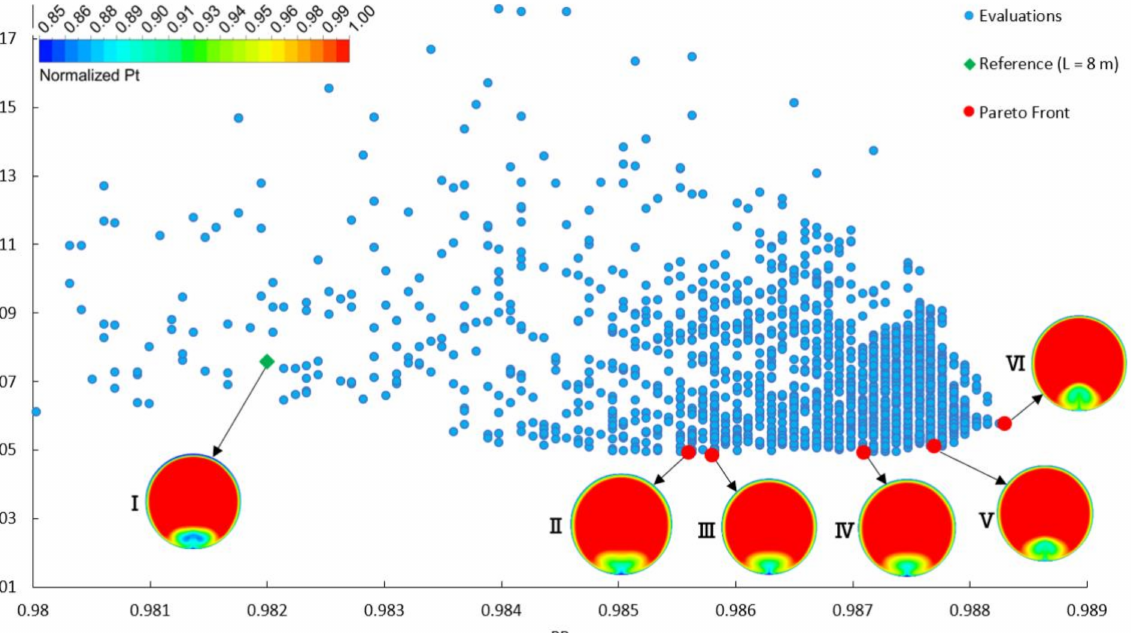
Figure 14. Evaluation history and Pareto front for the S-duct optimization (thumbnails show the normalized total pressure distribution at the engine